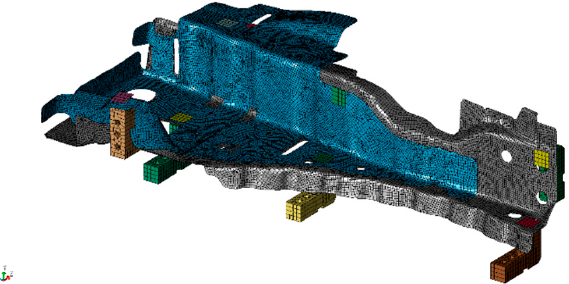
Figure 13. Finite element model for vehicle parts and clamps. Blue is the upper part, gray is the lower part, and the others are clamps.